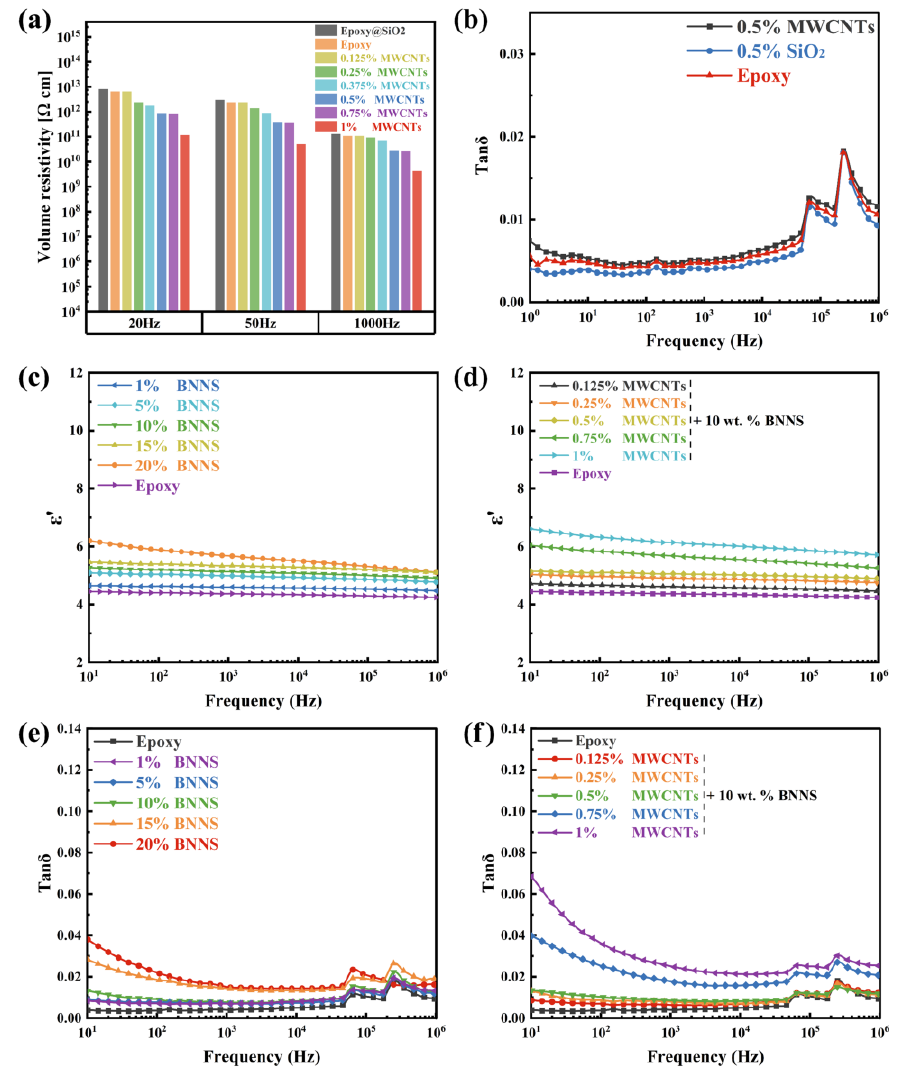
Figure 4. ( a ) Resistivity of composites with different contents of MWCNTs@AGE (All samples contain SiO 2 ); ( b ) dielectric loss of pure epoxy, epoxy/SiO 2 @KH560 and epoxy/MWCNTs; ( c , d ) dielectric constant of composites with BNNSs and MWCNTs@AGE; ( e , f ) dielectric loss of composites with different contents of BNNSs and MWCNTs@AGE (the samples with different concentrations of MWCNTs contain the same amount of BNNSs. All samples contain SiO 2 ).